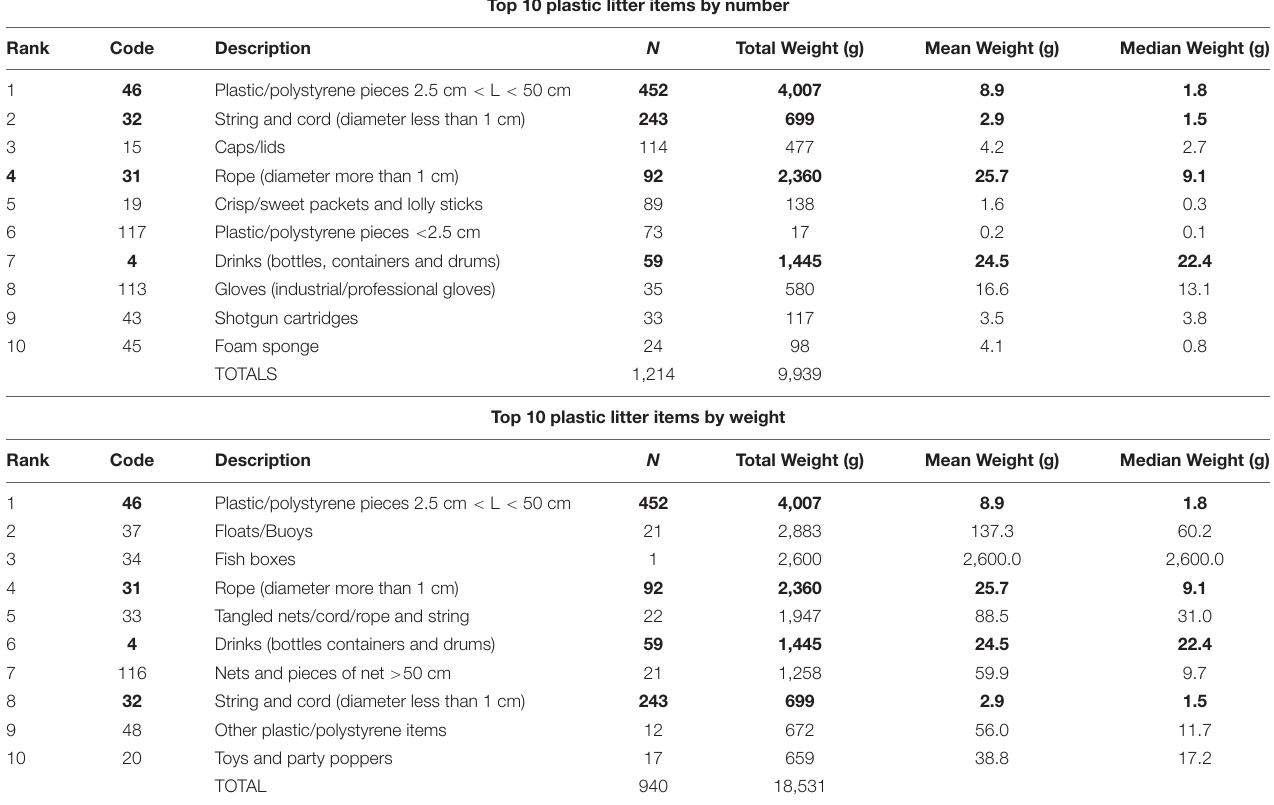
TABLE 2 | The ten most common plastic beach litter items by number and by weight.